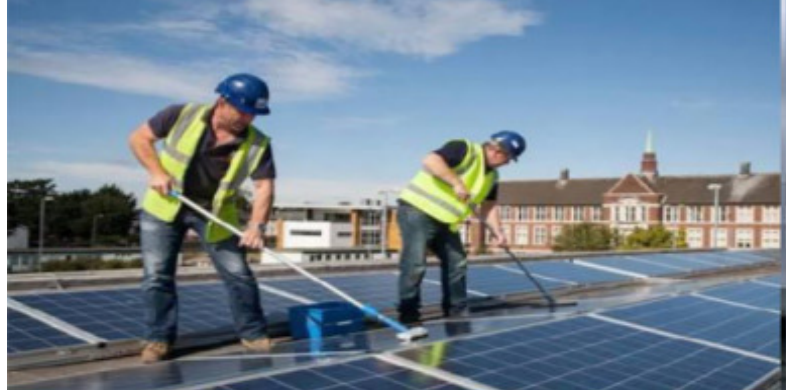
Figure 29. Manual cleaning of PV panels [135].